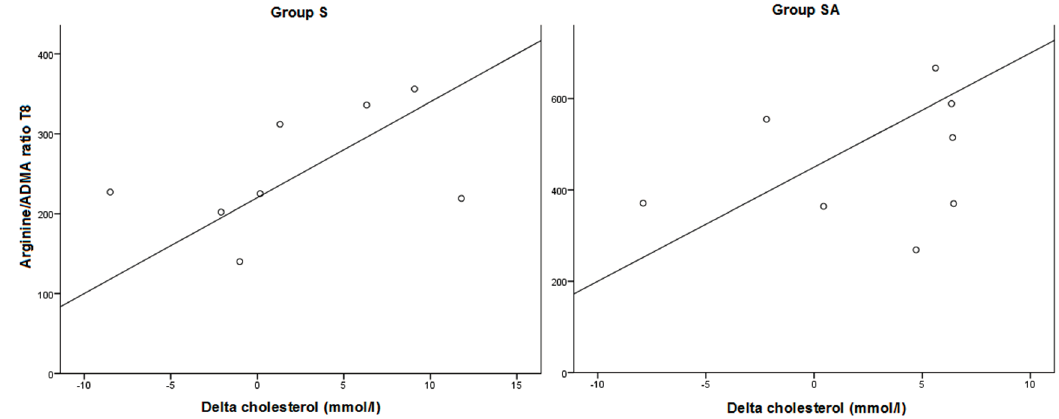
Figure 3. Pearson correlation between arginine/ADMA ratio and the difference in cholesterol levels over time in the statine ( n = 8) and statine-arginine group ( n = 8) (S: r = 0.461, SA: r = 0.699).